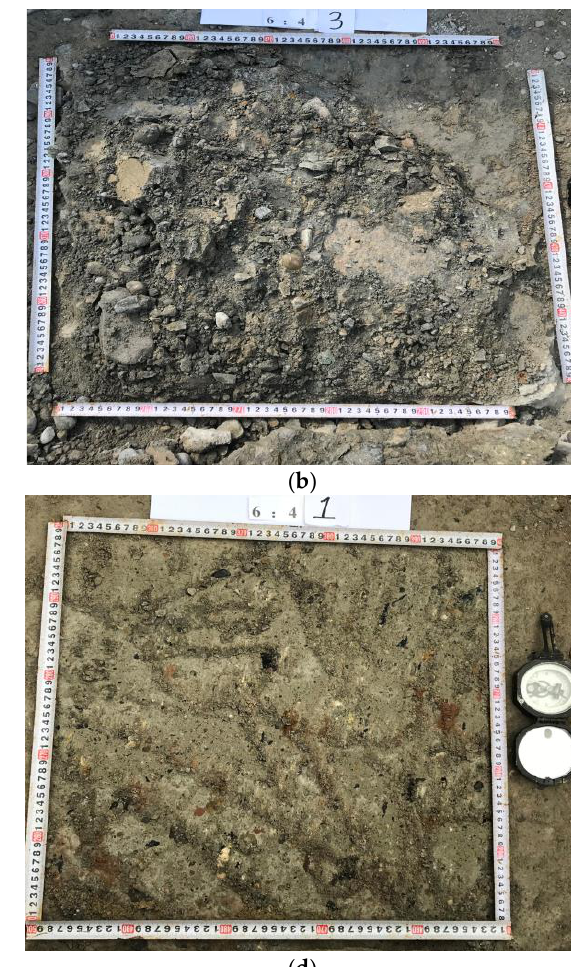
Figure 2. Shear stress–displacement curves of typical measurement points.